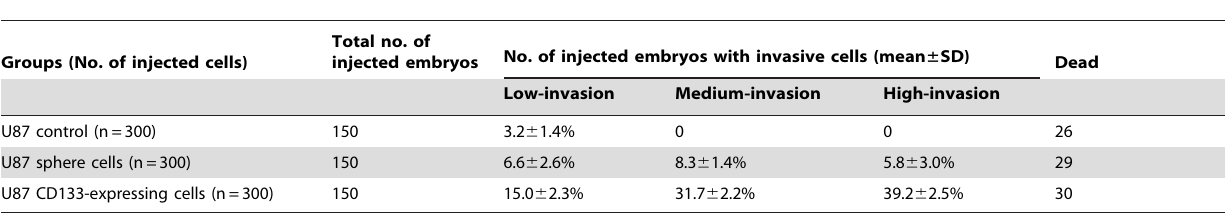
Table 1. Quantitation of invading tumor cells within zebrafish embryos injected with U87 cells.